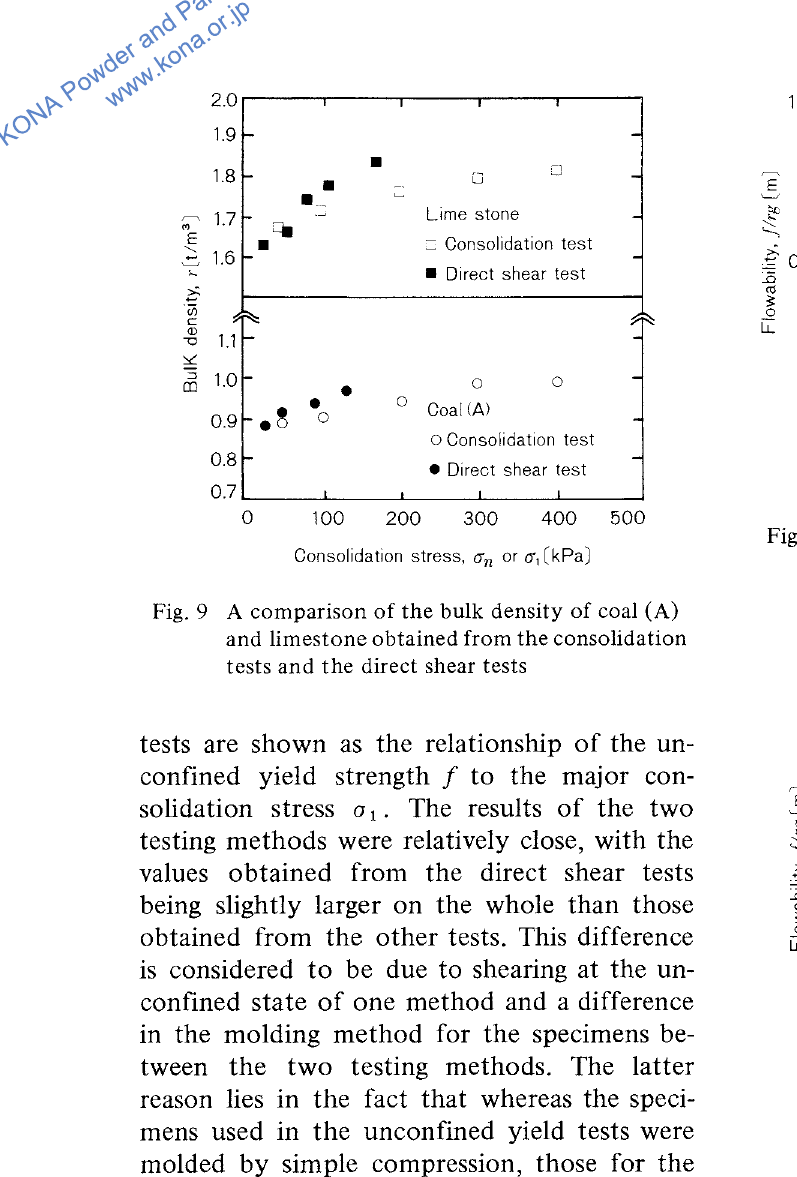
Fig. 9 A comparison of the bulk density of coal (A) and limestone obtained from the consolidation tests and the direct shear tests